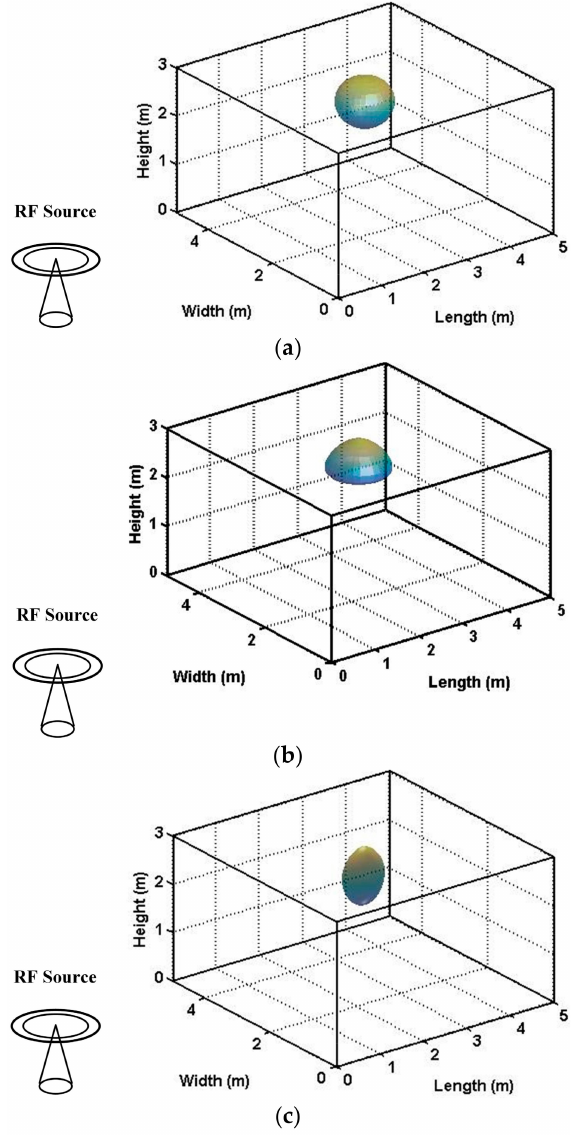
Figure 3. Typical indoor hybrid VLC/RF application scenario of ( a ) Lambertian optical beam, ( b ) LUXEON Rebel optical beam, and ( c ) asymmetric NSPW optical